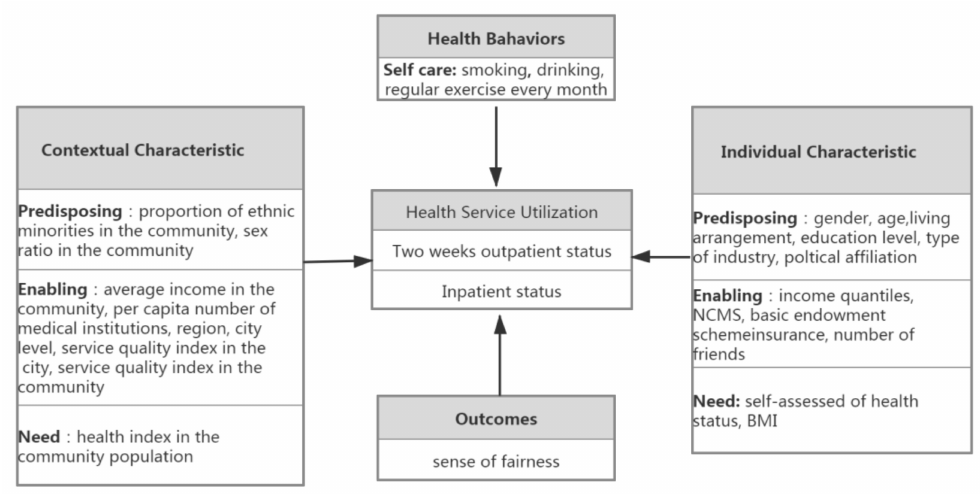
Figure 2. Revised Andersen Model (with appropriate